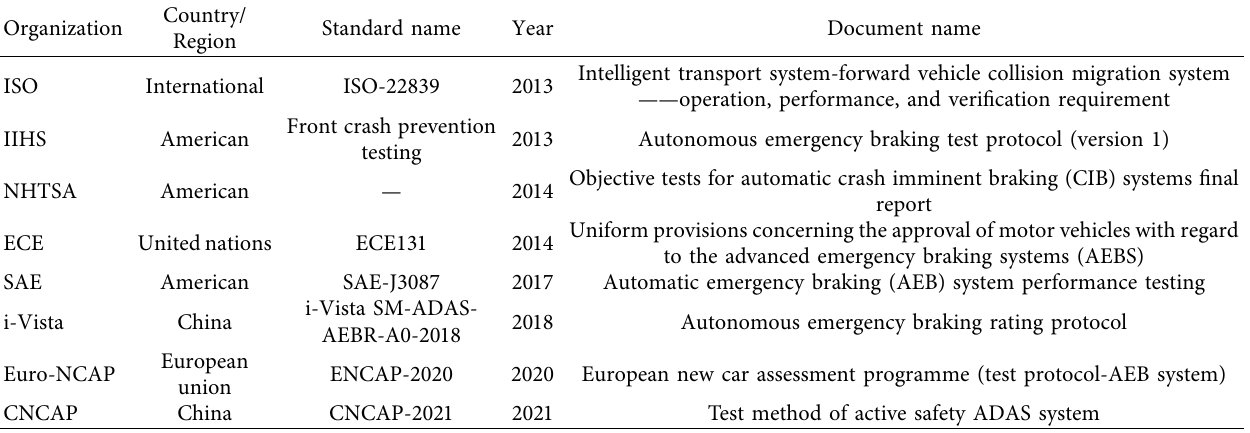
Table 2: International standards and test report.